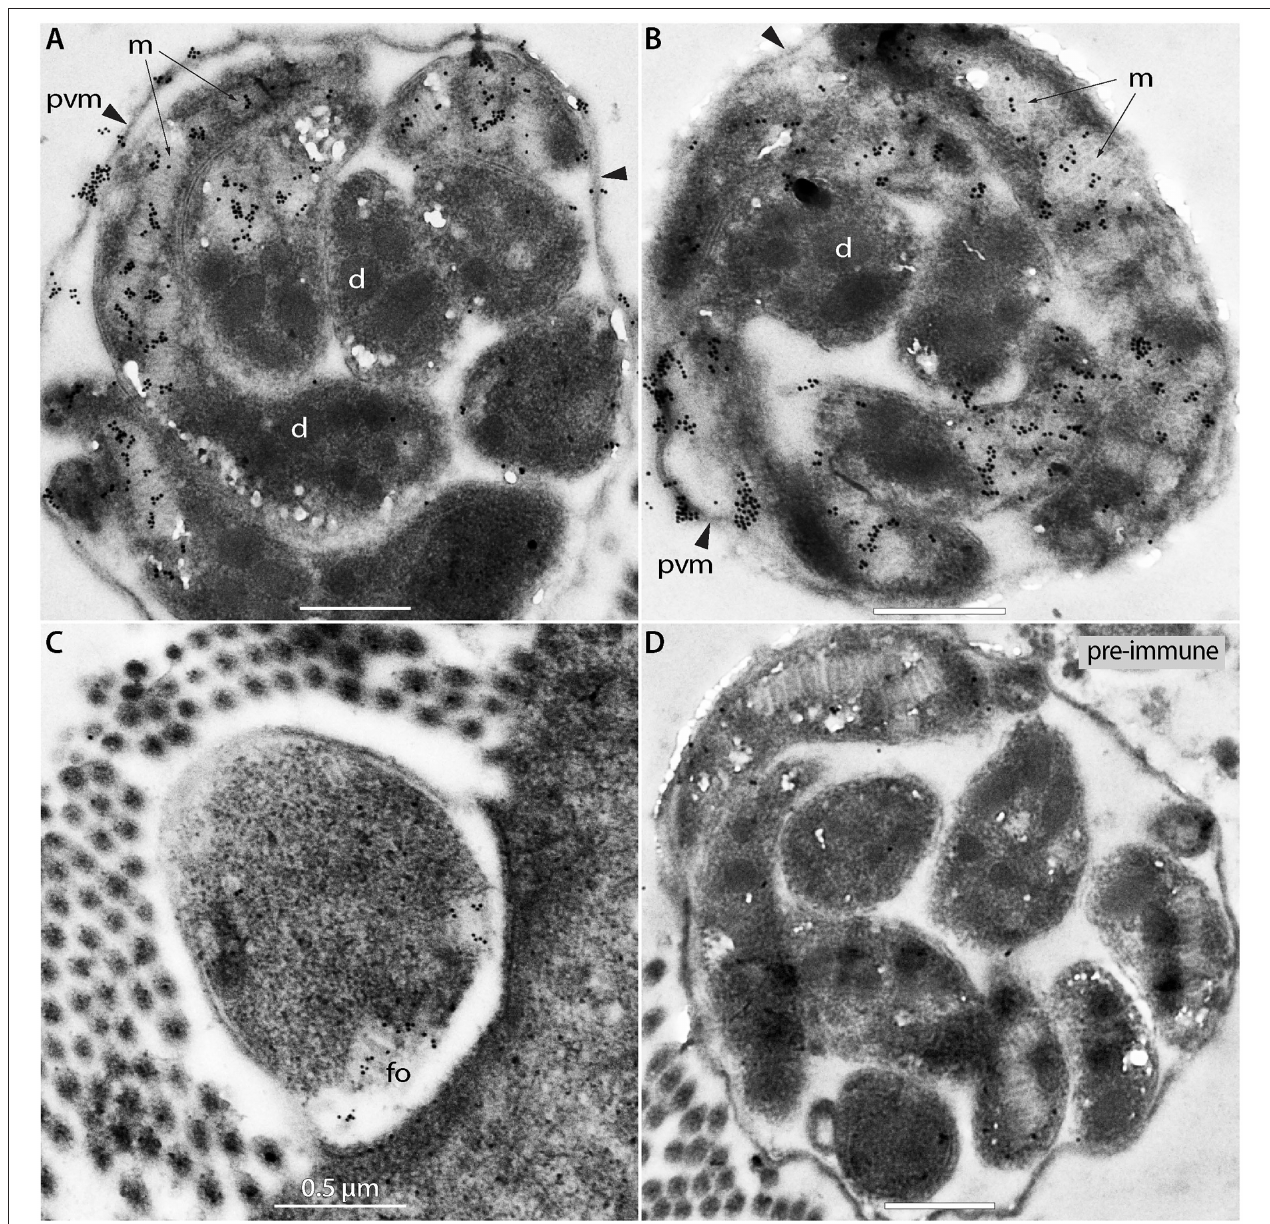
FIGURE 7 | Immunogold electron micrographs of intracellular meronts of Cryptosporidium tyzzeri labeled with anti-CpROM1 antibody (A–C) or pre-immune serum (D) . Specimens were obtained from a mouse ileum infected with C. tyzzeri . Gold particles are present over the micronemes (m; arrows) of intracellular merozoites, parasitophorous vacuole membrane (pvm; arrowheads) and a feeder organelle (fo). No gold particles were observed on dense granules (d).